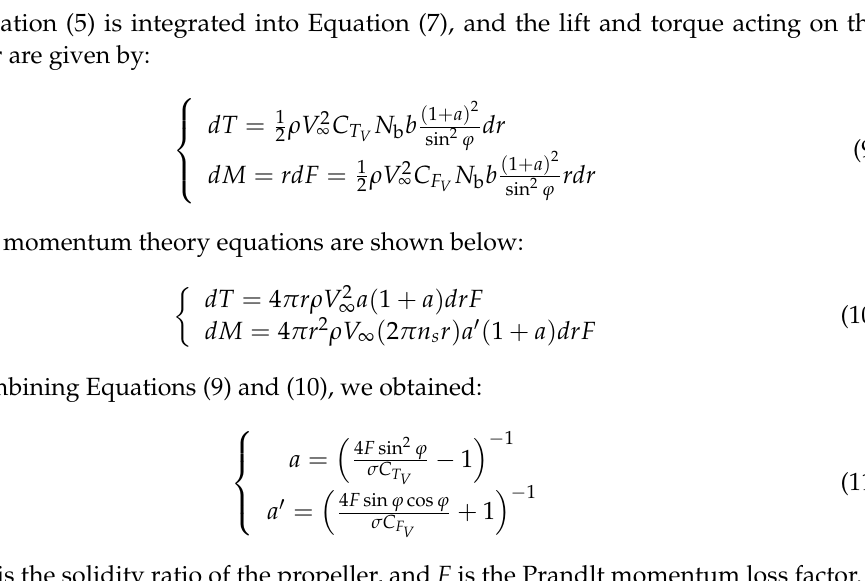
Figure 1. Forces and velocities acting on the blade